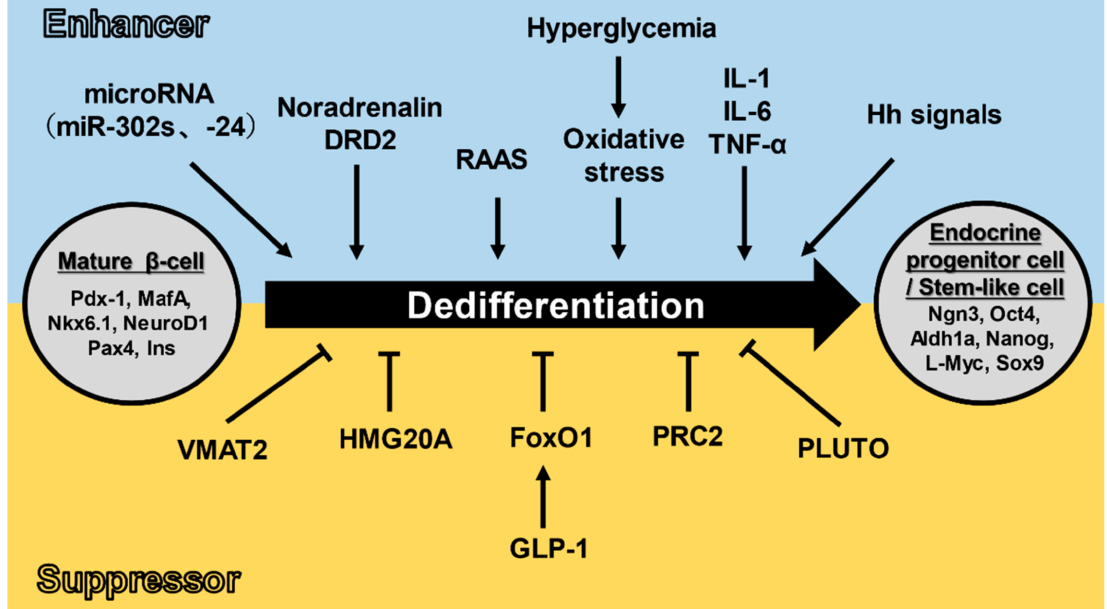
Figure 2. Mechanisms of dedifferentiation of pancreatic β -cells. Hyperglycemia, inflammatory cytokines (IL-1, IL-6, TNF- α ), Hh signaling, RAAS, miRNA, noradrenaline, and DRD2 have been reported to enhance β -cell dedifferentiation. Molecules/peptides such as FoxO1, PRC2, HMG20A, PLUTO, VMAT2, and GLP-1 have been reported to suppress β -cell dedifferentiation. Arrows indicate promotion and T arrows indicate